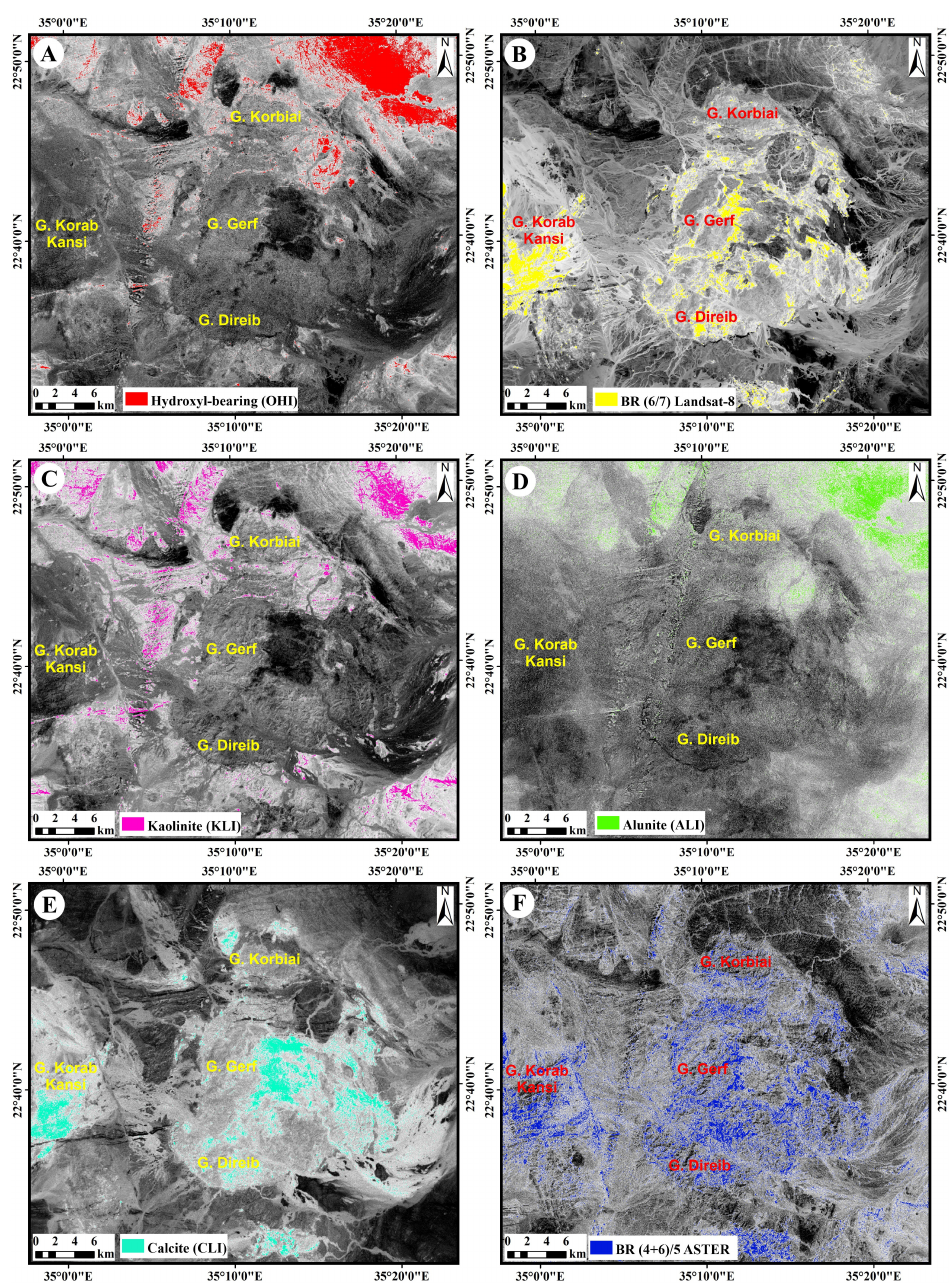
Figure 8. Mineral indices; ( A ) OHI = OH-bearing minerals, ( B ) band ratio 6/7 of Landsat-8, ( C ) Kaolinite index (KLI), ( D ) Alunite index (ALI), ( E ) Calcite index (CLI) and ( F ) Argillic zone using BR = (4 + 6/5) of ASTER. The gray-scale band ratios images of BR and Ninomiya et al. [71] were thresholded to extract the pixels that represent the target alteration zones/minerals at threshold con fi - dence value 92%. The threshold con fi dence value was determined as greater than con fi - dence value of 92% by (µ + σ ) and con fi dence value of 95% by (µ + 2 σ ) where µ and σ represent the mean value and standard deviation values of the resulting band ratio image, respectively. The estimated threshold values of these images are listed in Table 3. The ex- tracted pixels which re fl ect the spatial distribution of the alteration zones or minerals are superimposed on in their images with a certain color such as red, magenta, green, cyan,